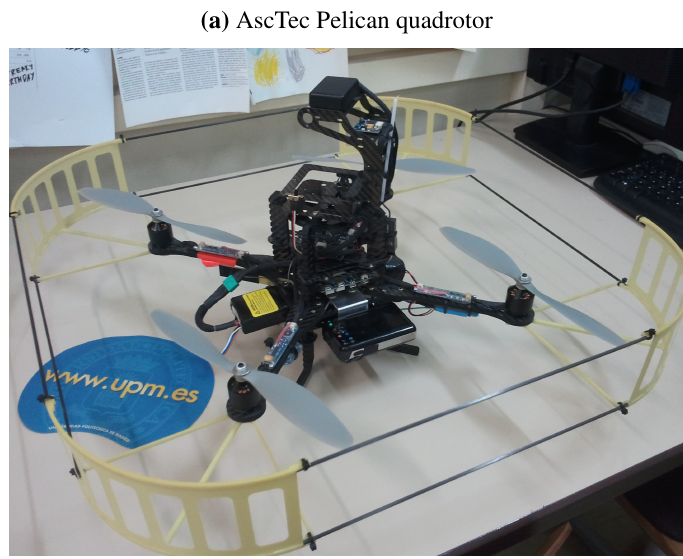
Figure 6. Hardware used in the experiments. (a) shows an image of the AscTec Pelican Quadrotor used to perform the experiments and (b) shows the PointGrey Firefly Camera used to take the